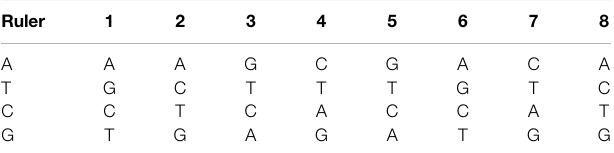
TABLE 3 | DNA triploid mutation